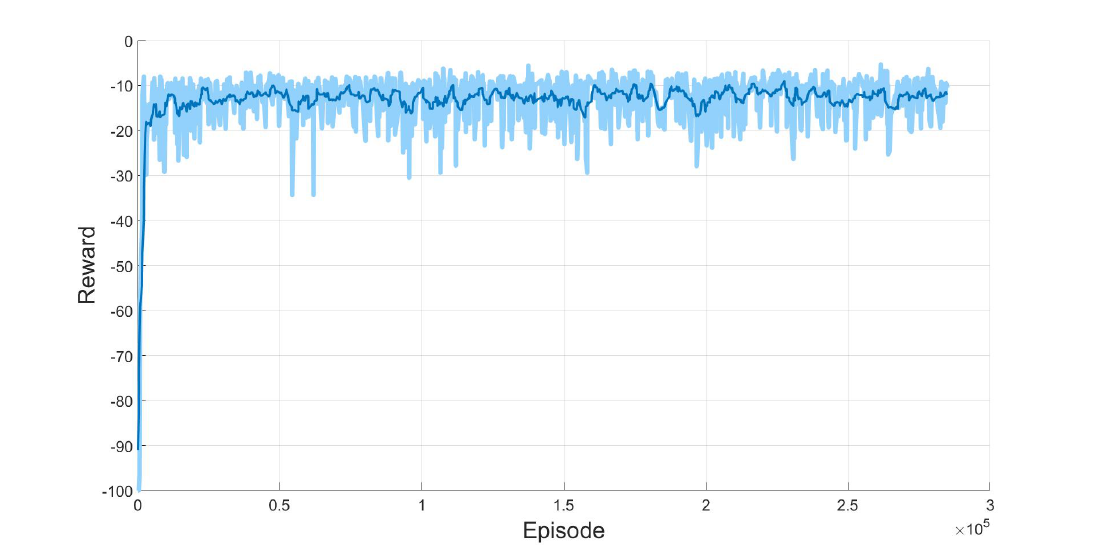
Figure 7. Reward from learning for two 3-DOF manipulators.